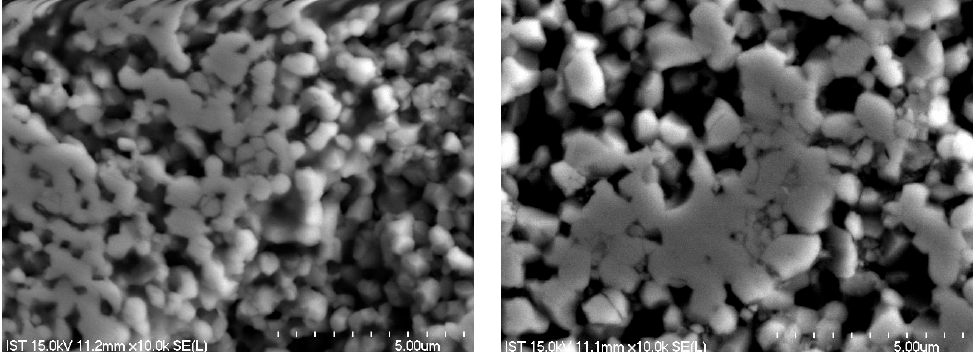
Figure 8. FESEM images of sintered KZM-100-MOD-Y ( left ) and BT02-MOD-Y ( right ).